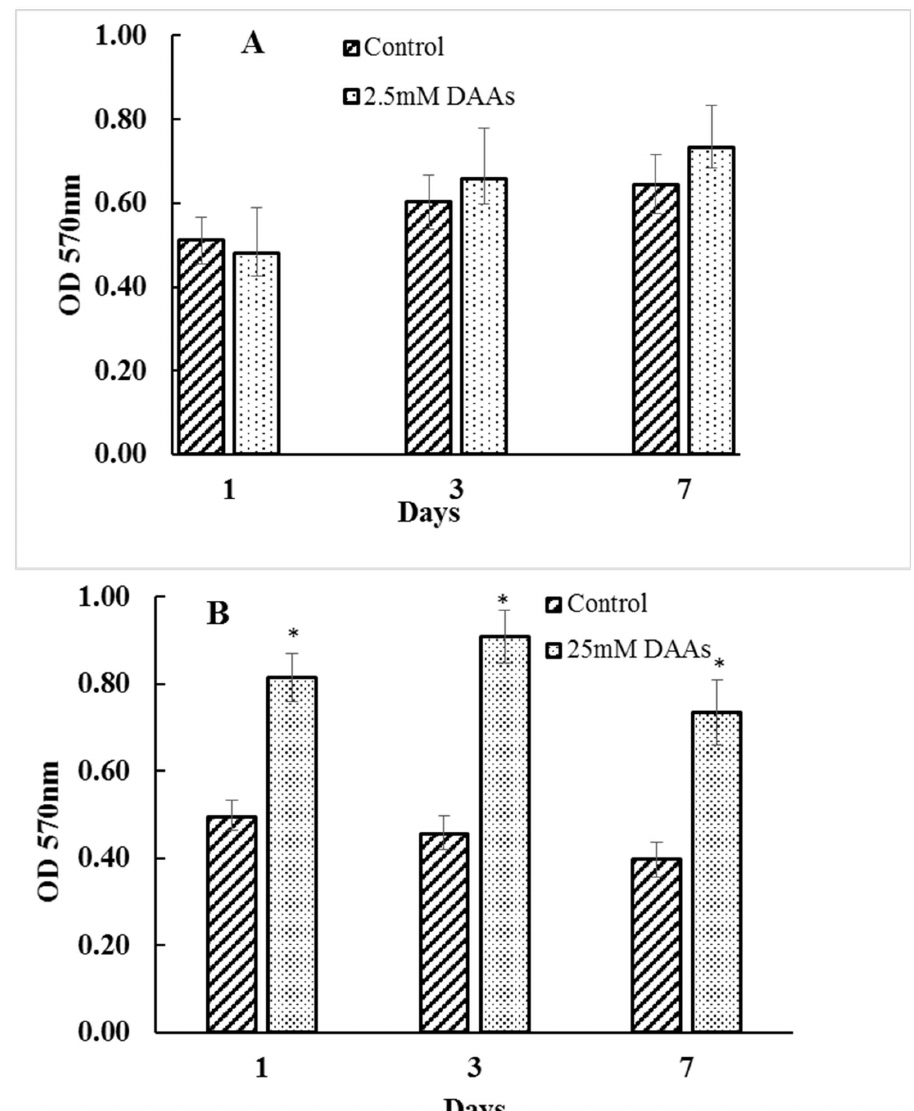
Fig 4. Mean optical density of the Planktonic cultures during biofilm growth. The mean optical density (570nm) of the planktonicculture removedafter 1, 3 and 7 days incubation in the presenceof 2.5mM (A) or 25mM (B) L-Leu, L-Met and L-Trp (0.25mM D- Tyr in both treatments). Asterisk denotes a significant reduction (p < 0.05)in biofilm comparedto the control (no